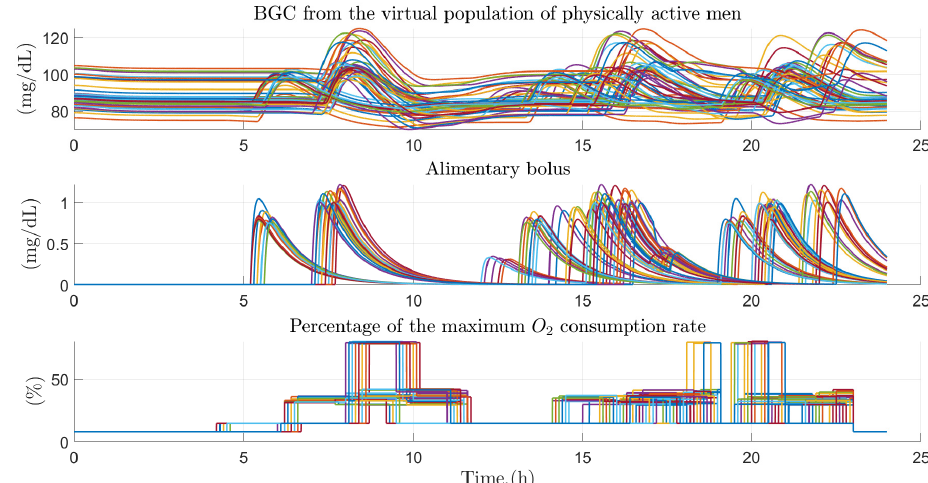
Figure 8. Effect of primary and secondary factors on the virtual population of physically active men. Effect of diet and physical activity on glucose concentration in the virtual population of 50 physically active